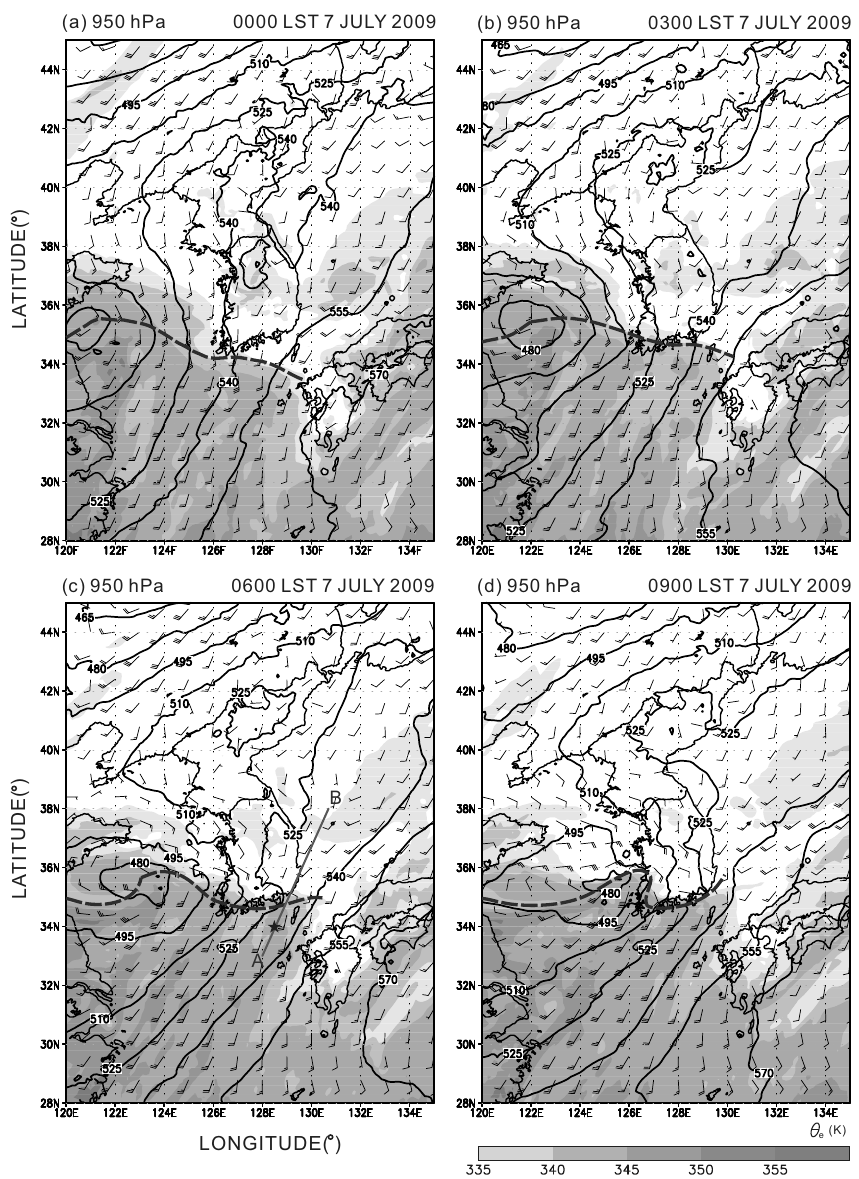
Figure 5. Mesoscale analysis of horizontal winds (ms − 1 , barbs), geopotential height (gpm, solid contours), and equivalent potential tem- perature ( θ e , K, shaded) at 950hPa for (a) 00:00, (b) 03:00, (c) 06:00, and (d) 09:00 LST 7 July 2009. Contour intervals are 15gpm for geopotential height, and full (half) barbs represent winds of 5 (2.5)ms − 1 . The location of the front is also plotted as a dashed line. In (c) the line A–B shows the location of the vertical cross section used in Fig. 6 and the asterisk at 34 ◦ N, 128.5 ◦ E depicts the sounding location shown in Fig.